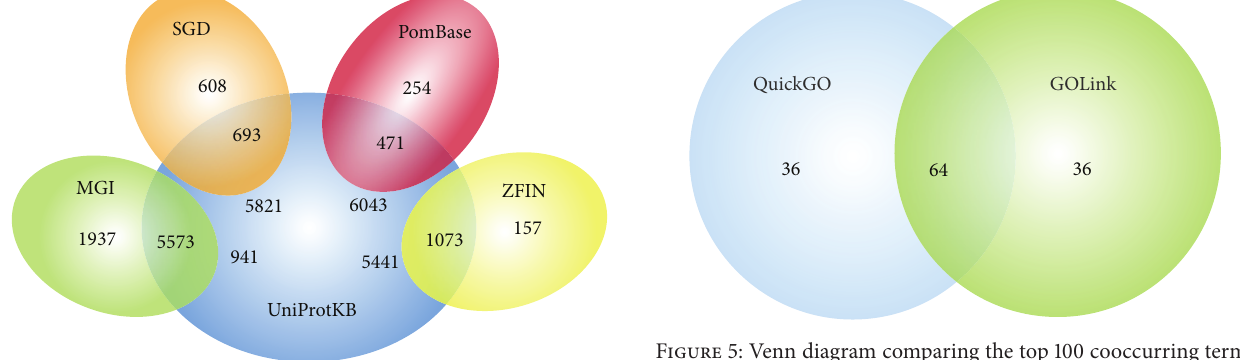
Figure 4: The effect of applying GOLink’s annotation source database filter. Results from four annotation sources (“PomBase,” “MGI,” “SGD,” and “ZFIN”) are compared in separate pairwise Venn diagrams to results obtained using “UniProtKB” as the annotation source. All analyses used the query term “regulation of gene expression” and applied the “!IEA” evidence code filter. As expected, the majority of terms in the results of each compared source database could also be found in UniProtKB with unique terms having relevance to each respective annotation source.